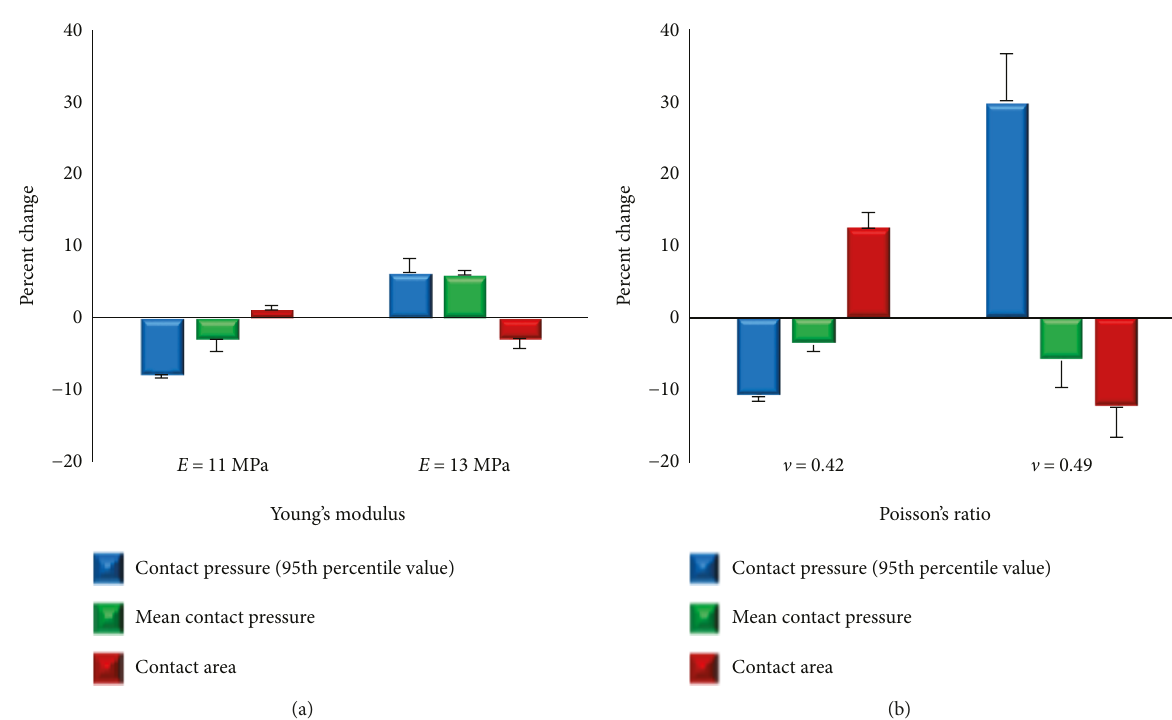
Figure 9: Percent changes in contact pressure (95th percentile value), mean contact pressure and contact area due to alterations in cartilage material properties, Young ’ s modulus (a) and Poisson ’ s ratio (b). Error bars indicate standard deviations over the three loading conditions